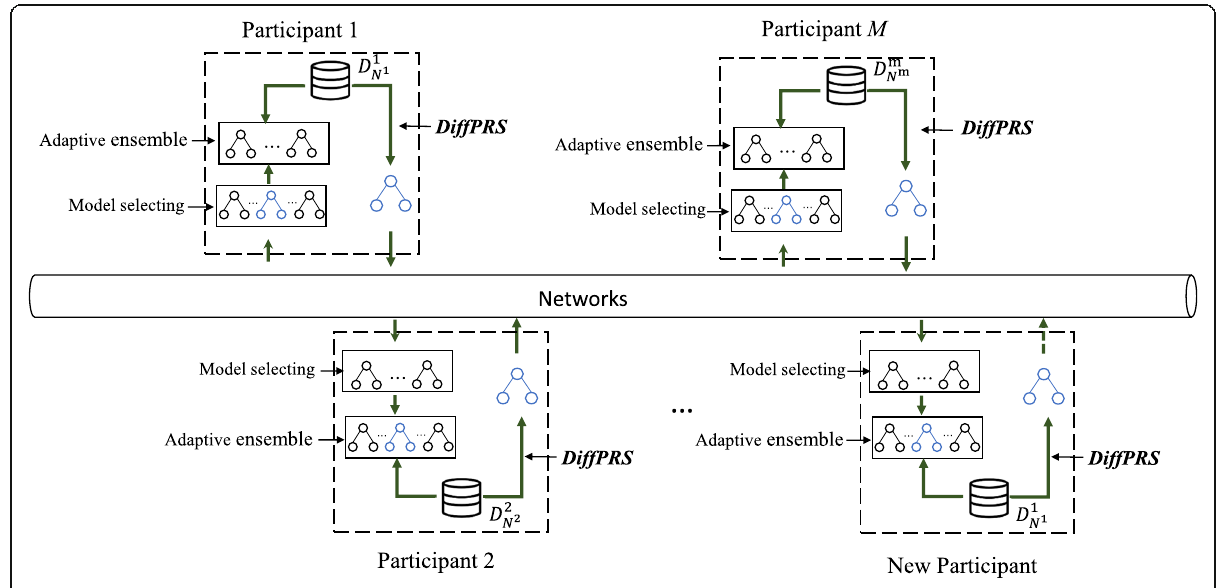
Fig. 1 An Overview of Differentially Private Distributed Data Mining